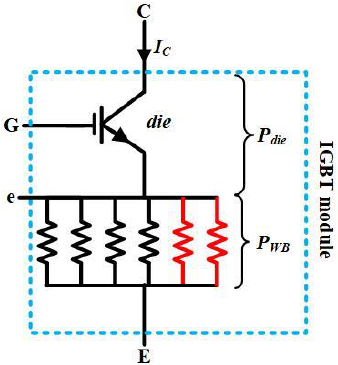
Figure 18. Power dissipation of IGBT module using Kelvin setup.